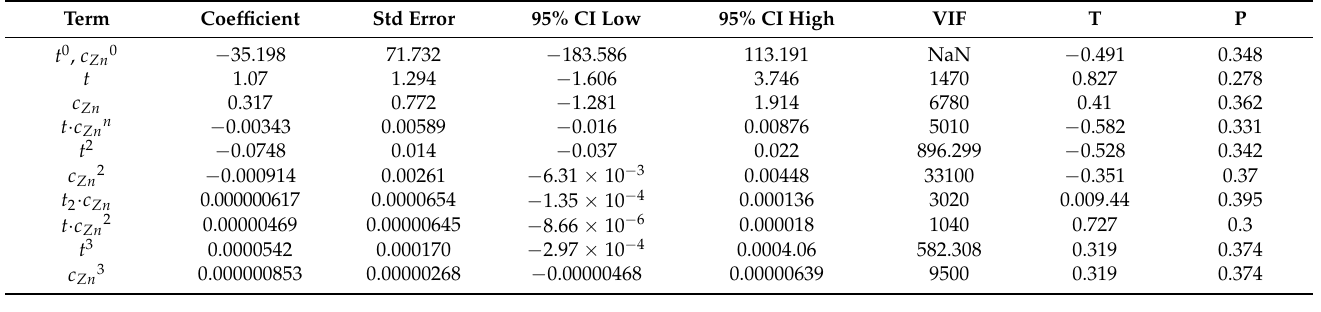
Table 8. Statistical characteristics of the quadratic regression by two variables for the mass of the lettuces.